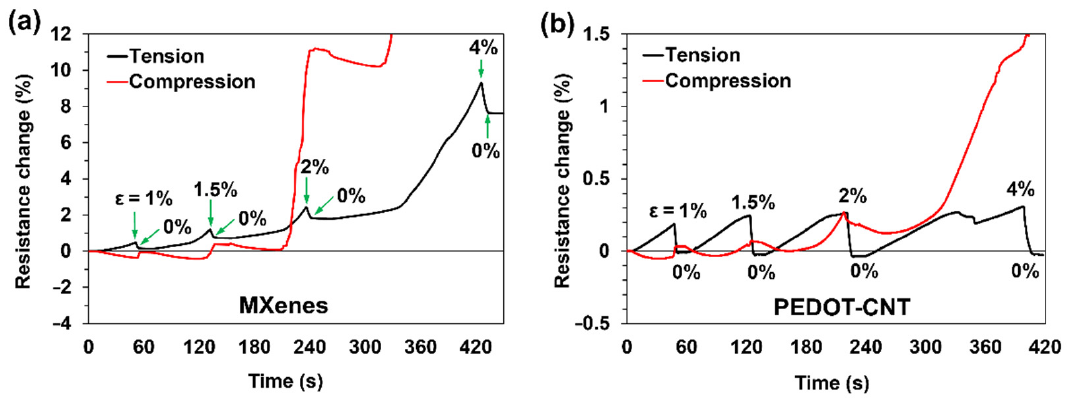
Figure 5. Resistance changes of tensiled and compressed surfaces under three-point bending at different flexural strains of: ( a ) MXene and ( b ) PEDOT-CNT coatings.